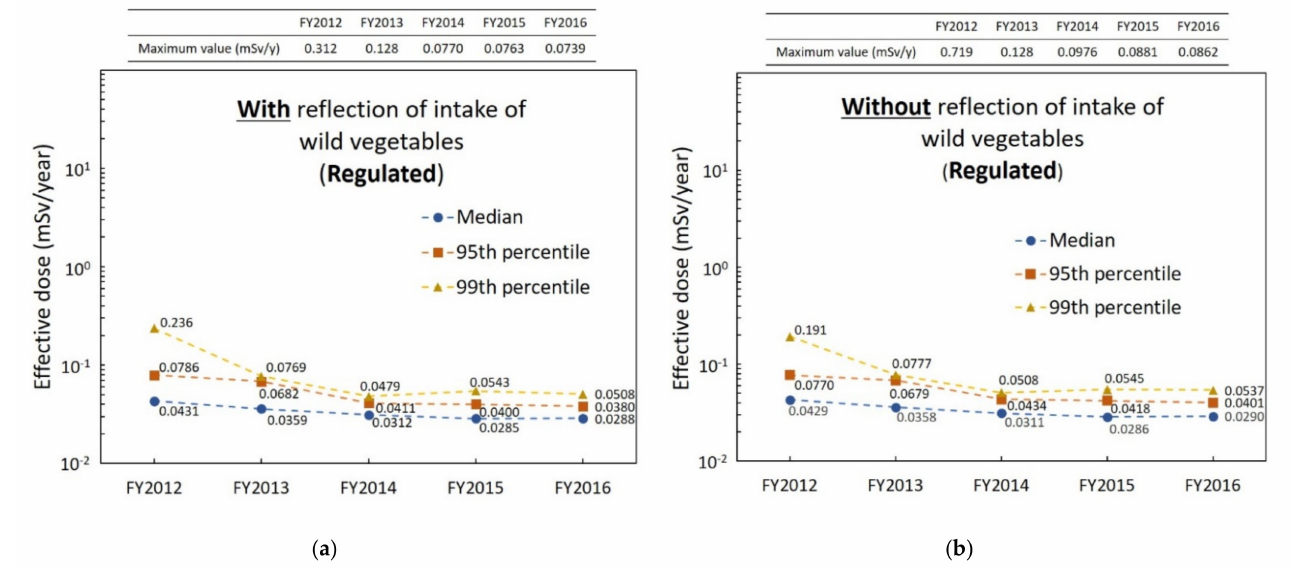
Figure 5. Longitudinal change of internal exposure dose for the case assumed to be “regulated”: ( a ) with and ( b ) without the reflection of intake of wild